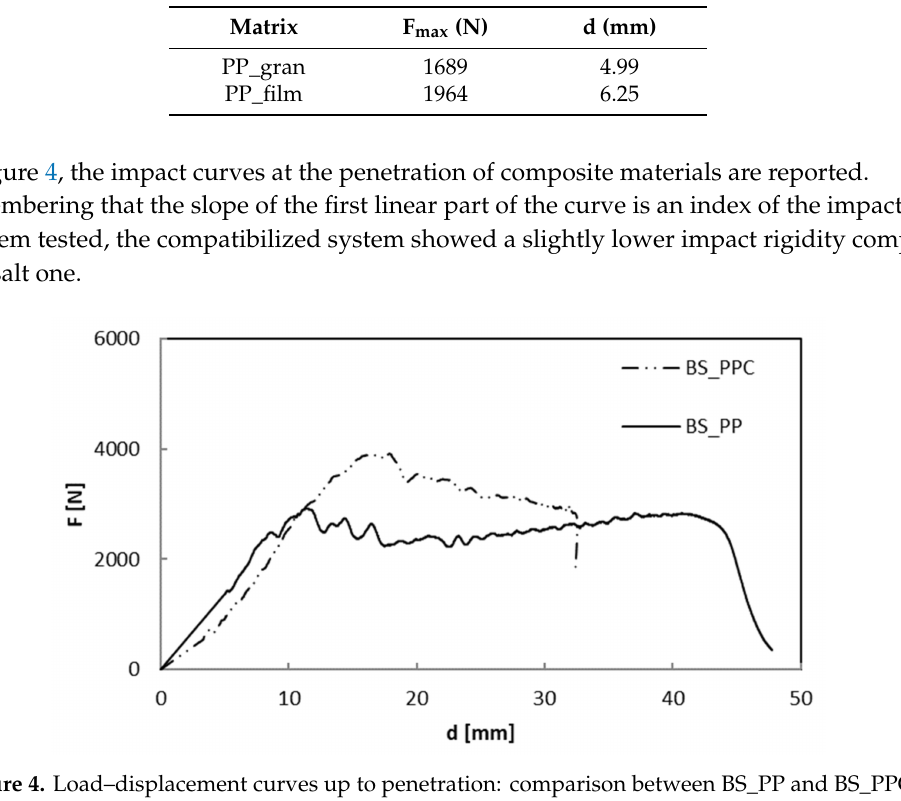
Figure 3. Load–displacement curves at penetration of PP granule and PP film-based samples. Table 2. Impact parameters at penetration for matrix.